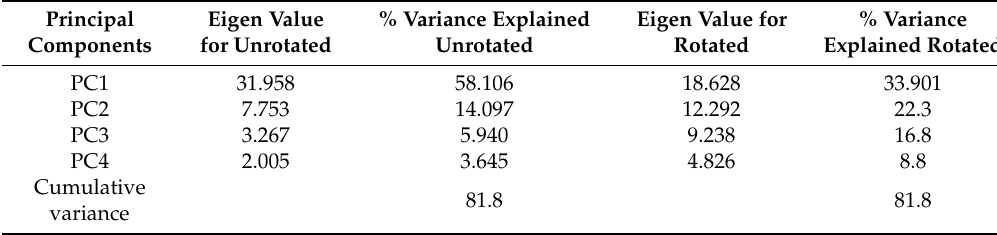
Table 2. Principal component analysis applied on the standardized precipitation index (SPI) for the 55 stations in South